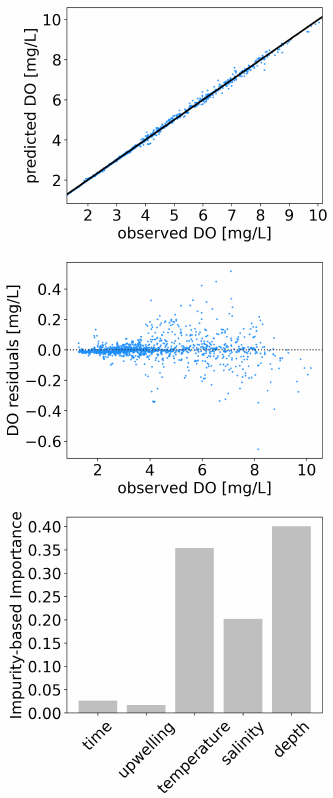
Figure 4. Offshore model relational plot for Random Forest Regression ( top ) with R 2 = 0.997, along with the residuals plot ( center ) and relative impurity-based importance ( bottom